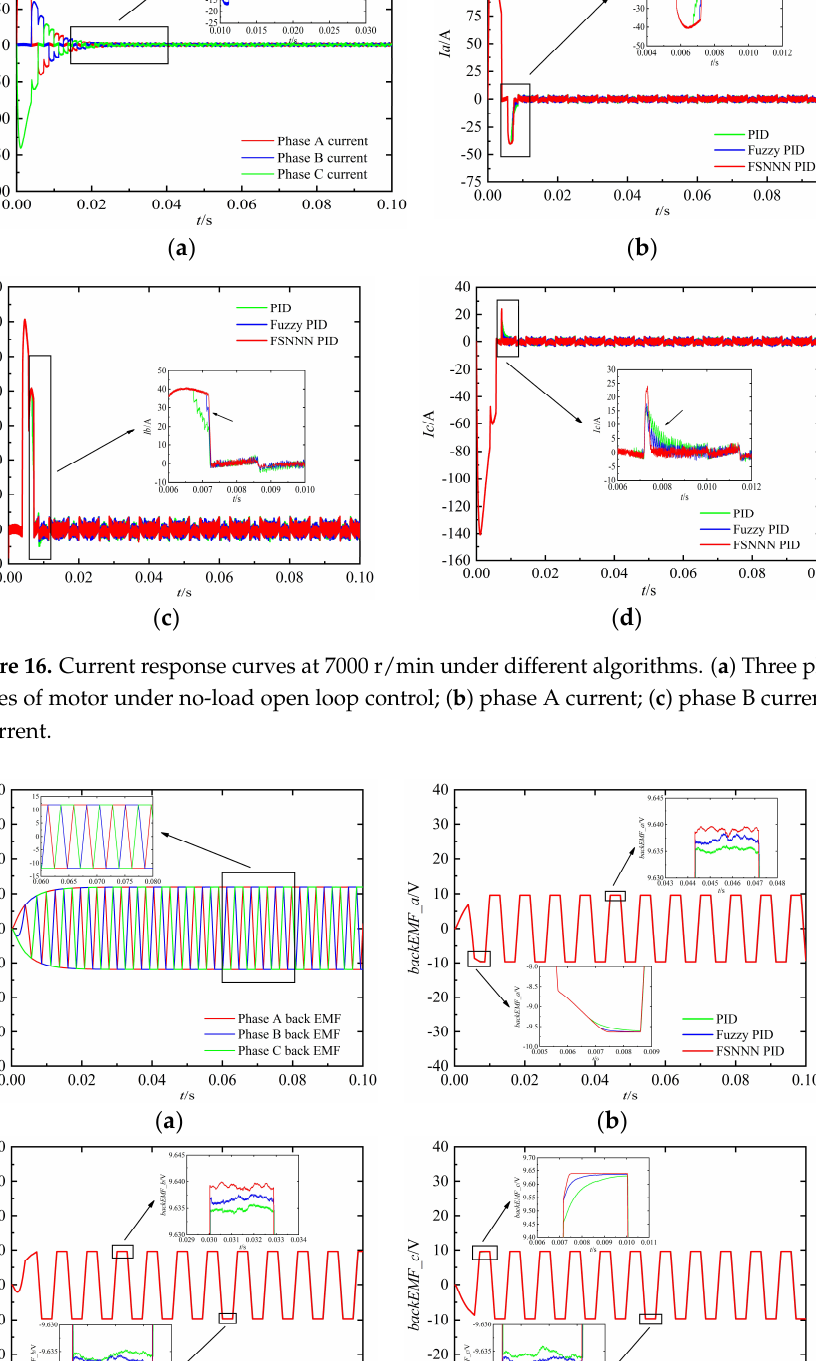
( f ) Figure 15. Speed step response of BLDCM at different reference speeds: ( a ) 5000 r/min; ( b ) 5500 r/min; ( c ) 6000 r/min; ( d ) 6500 r/min; ( e ) 7000 r/min; ( f ) 7500 r/min. Table 4. Motor speed step response of 7000 r/min under different algorithms. Algorithm Performance Index